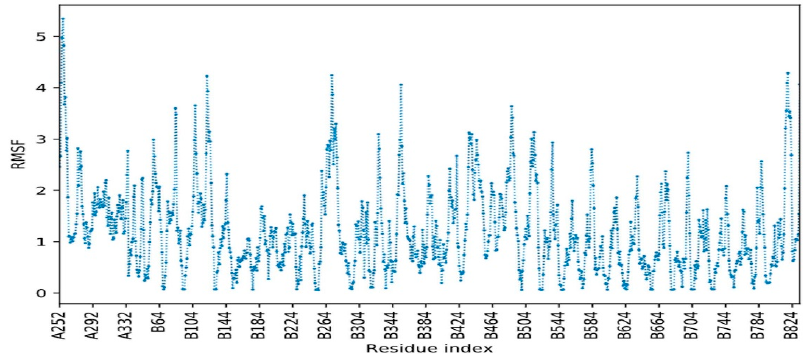
Figure 9. RMSF of chain A (vaccine construct) and B (TLR receptor) of the docked complex. Residue starting with A belong to chain A, while those starting with B reflect chain B residues.